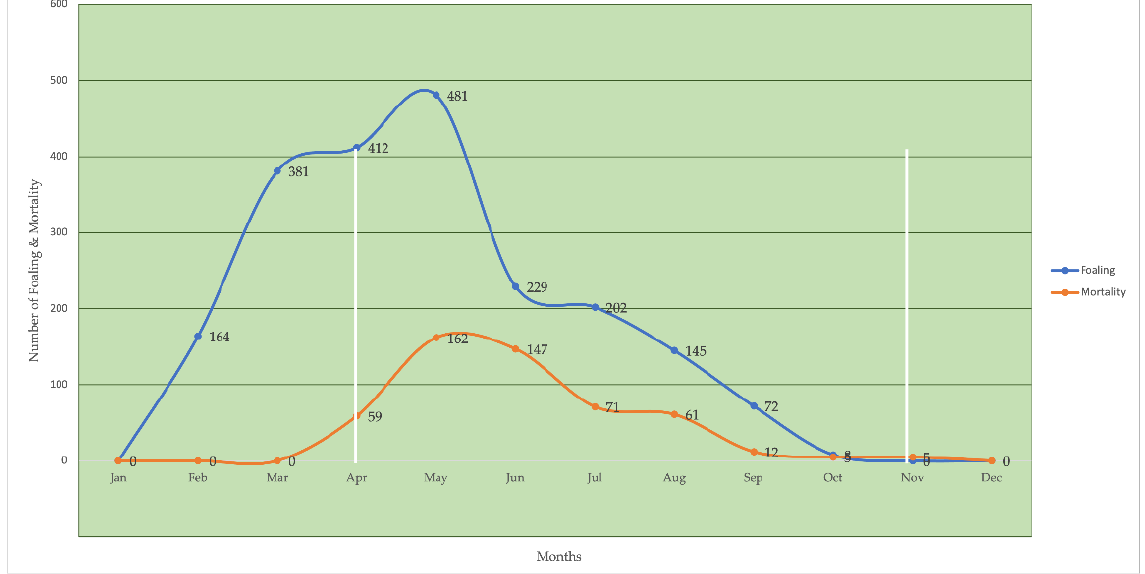
Figure 3. Foaling (vivinatality) and monthly mortality in Esperia’s ponies among the months. The analysis of the data also allows us to observe that in the months of December, January, February, and March, there are no predatory attacks, which would indicate a different trophic choice by the predators, probably justified by the absence of foals older than two months but less than six months of age, in the predation